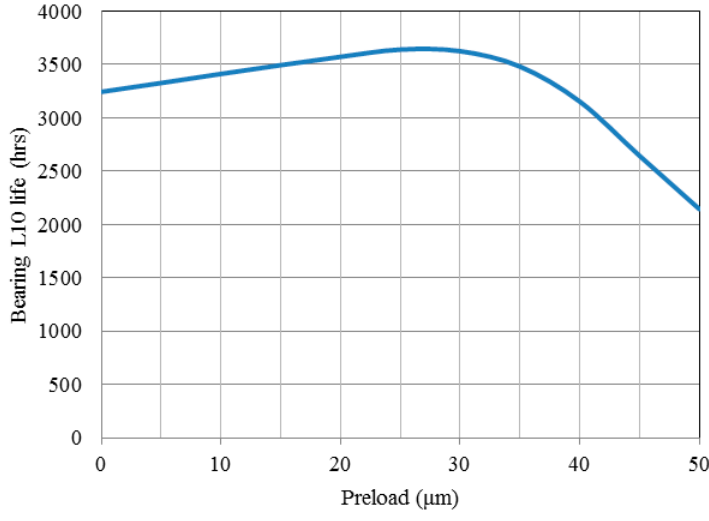
Figure 10. Bearing life over preload of hub bearing.